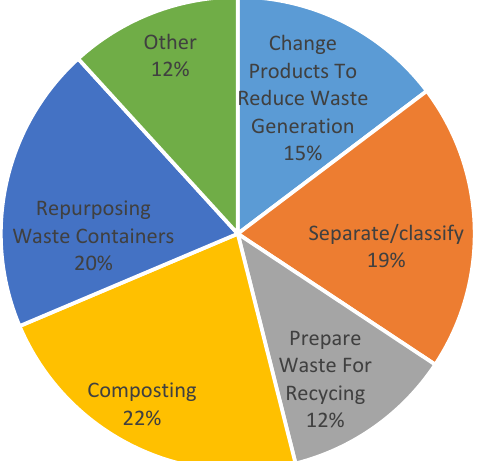
Fig. 10: Changes respondent willing to make for improved waste management in Saint Lucia